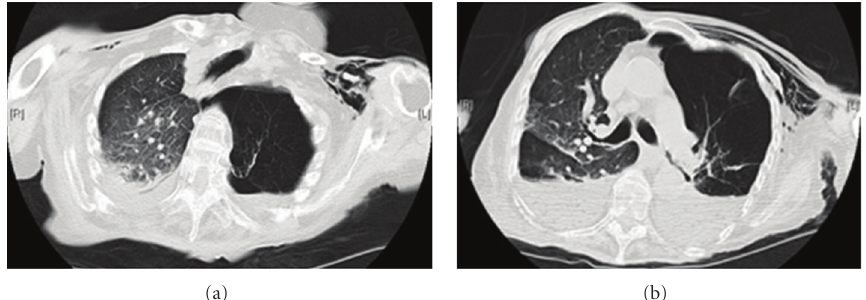
Figure 25: Axial CT scans on the patient in Figures 24 and 25 show that the chest drain was placed in bullous emphysema.